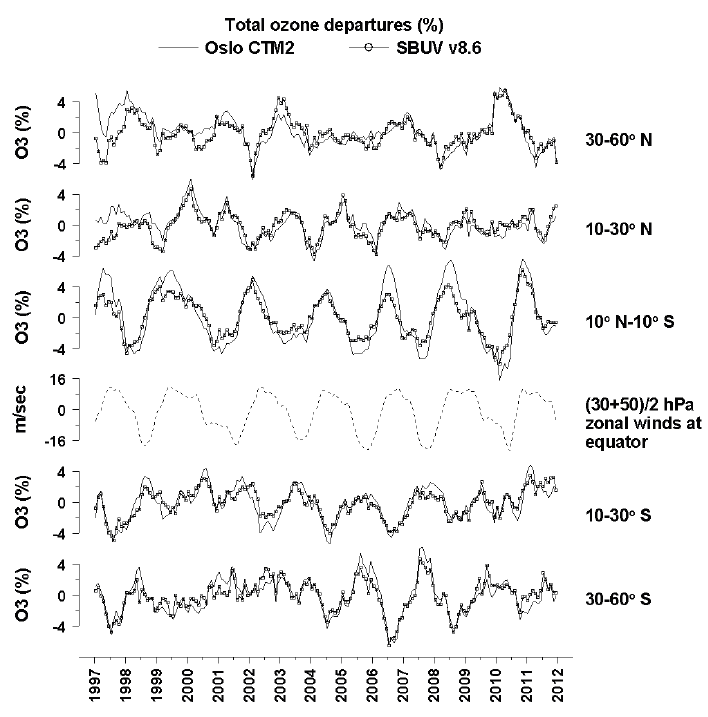
Figure 4. Column ozone variations, modeled (Oslo CTM2) and observed (SBUV) for different latitude zones between 1997 and 2012 (updated from